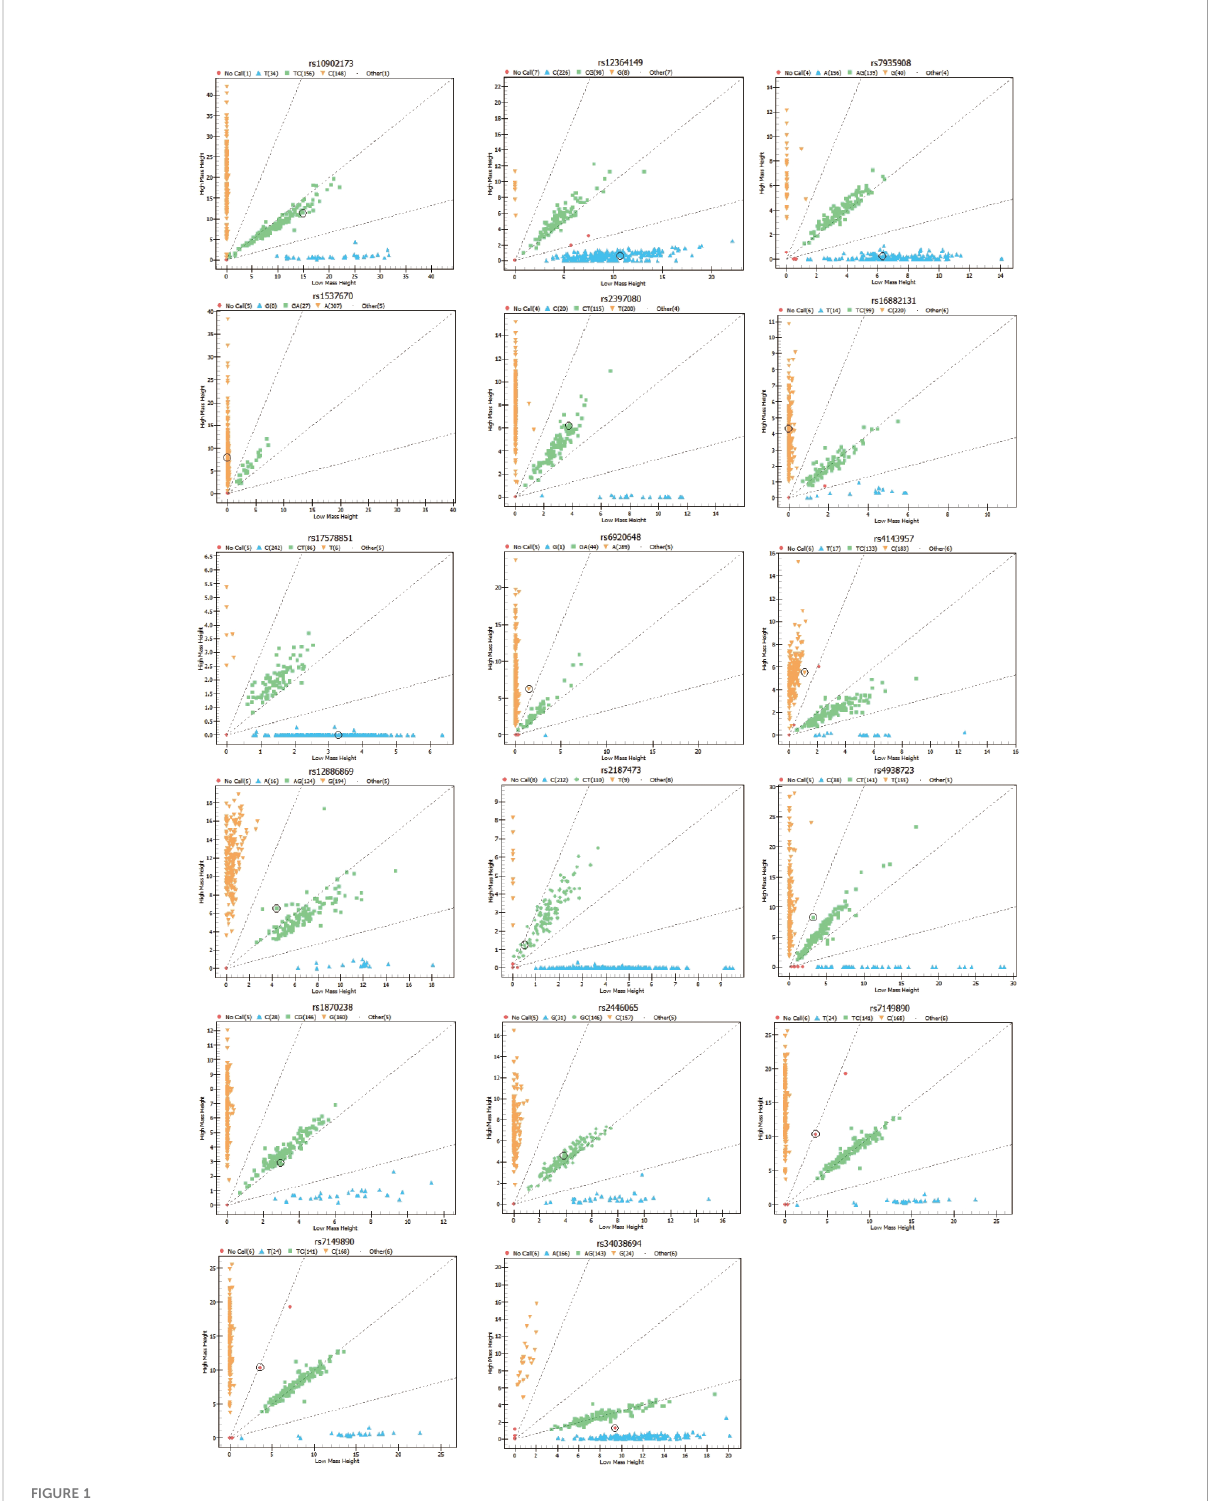
FIGURE 1 The genotype plots of miRNA polymorphisms. The X and Y axes represent the kurtosis of genotypes, respectively. The red square represents no call; the blue upright triangle, the green square, and the orange inverted triangle represent three different genotypes, respectively. In a good clustering plot, the two homozygous types are close to the horizontal axis and the vertical axis, while the heterozygous types are between them, showing a 45-degree angle. Clustering performance shows the evaluation of clustering ef fi ciency, which ranges from 0 to